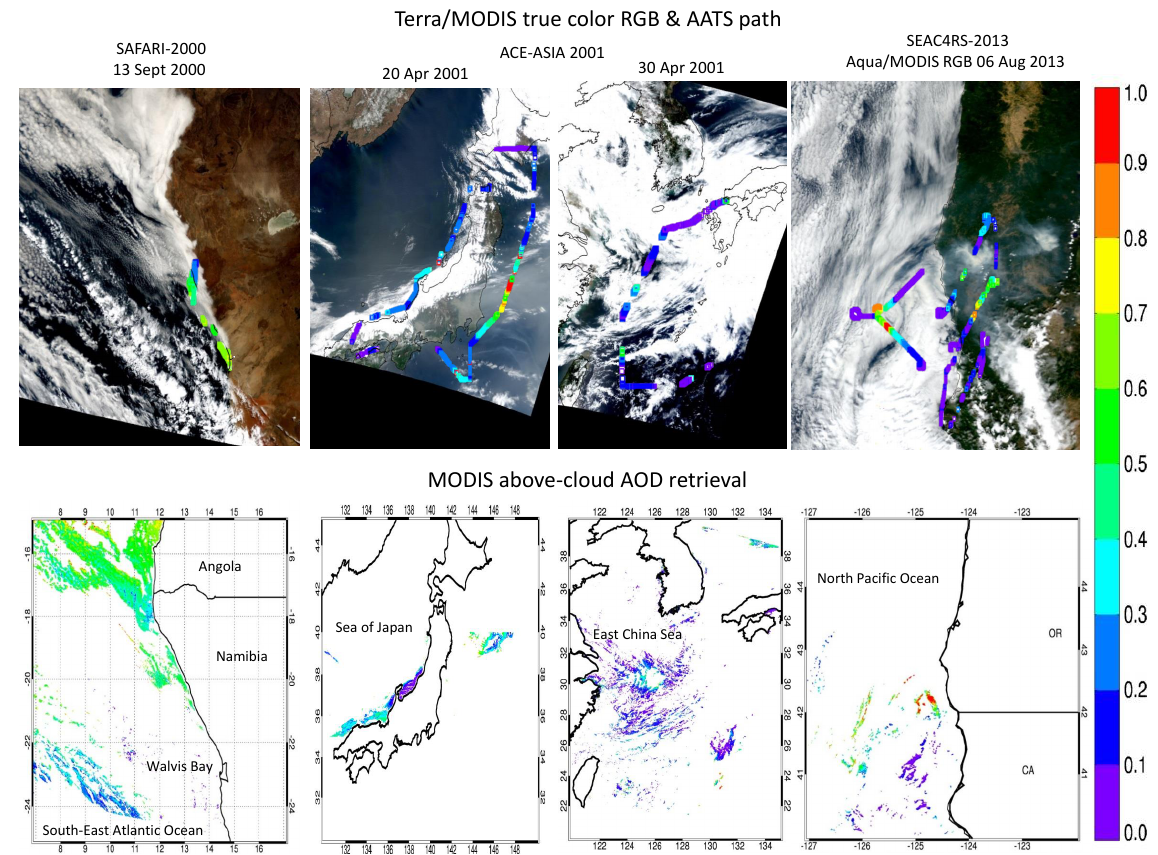
Figure 2. Top: true-color RGB images captured by MODIS superimposed with AOD (500nm) measured by AATS-6,-14/4STAR on 13 September 2000, 20, 30 April 2001, and 6 August 2013 during SAFARI-2000, ACE-ASIA 2001, and SEAC4RS 2013, respectively. Bottom: spatial distribution of above-cloud AOD (500nm) retrieved from MODIS for the respective